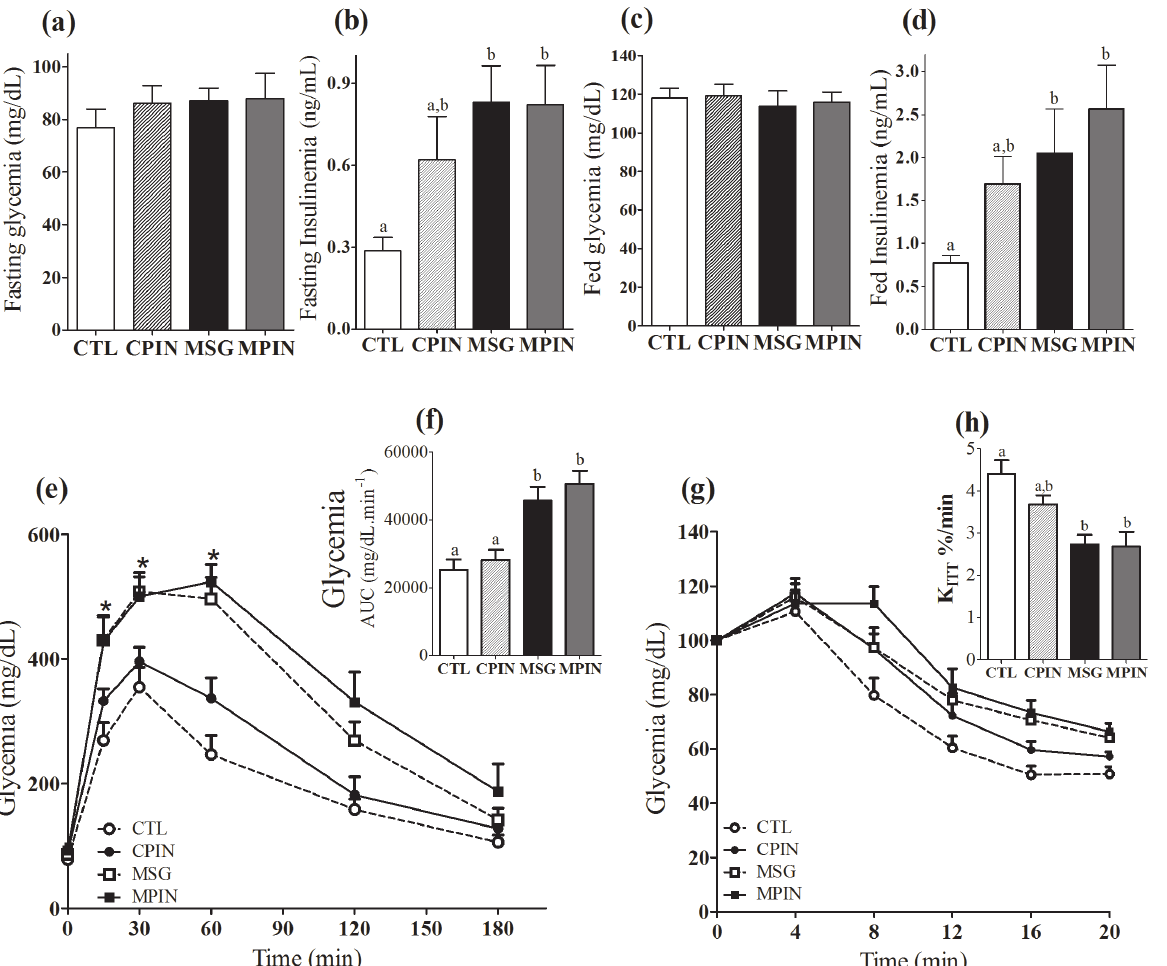
Figure 3. D-pinitol treatment did not change glucose homeostasis parameters in MSG-obese mice. Means ± SEM of fasting and fed glycemia (a and c), insulinemia (b and d) in CTL (n = 12), CPIN (n = 12), MSG (n = 12) and MPIN (n = 14) mice. Changes in glycemia during the ipGTT (e) or ipITT (g) in CTL (n = 11), CPIN (n = 11), MSG (n = 12) and MPIN (n = 11) mice. Means ± SEM of the total glycemia during ipGTT (f), expressed by the AUC; and insulin sensitivity expressed by the K (h). Different letters over the bars represent significant differences (Kruskal-Wallis followed ITT by Dunns post-test, with exception of data in figures b and f, which were analyzed by one-way ANOVA followed by Newman-Keuls post-test, P <